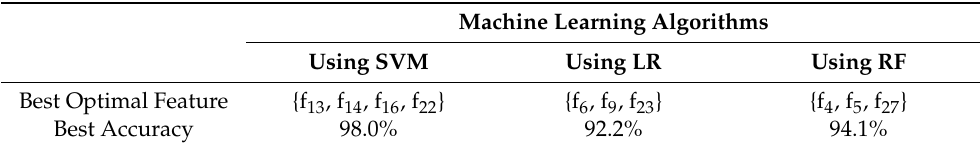
Table 6. Classification Accuracy of Best Optimal Features after Feature Selection with Wrapper Approach.